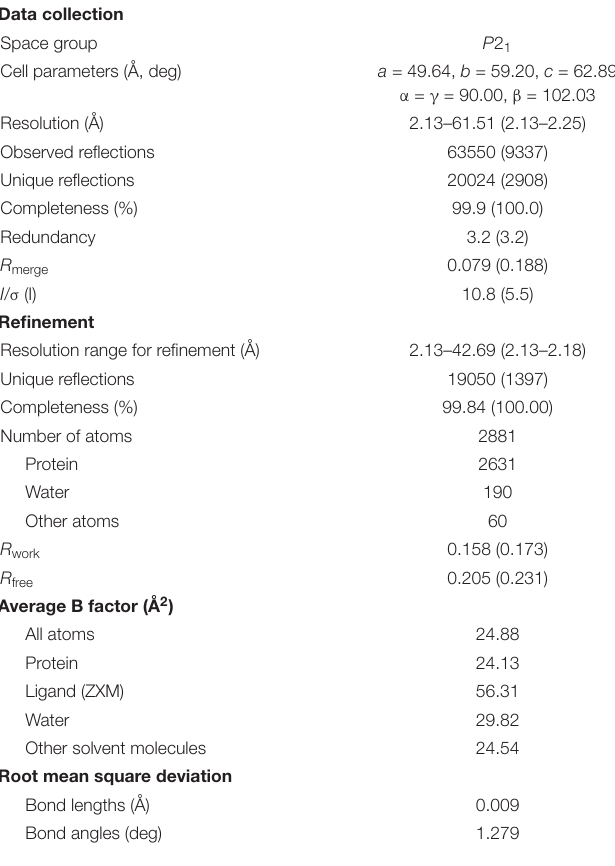
TABLE 3 | Data collection and refinement